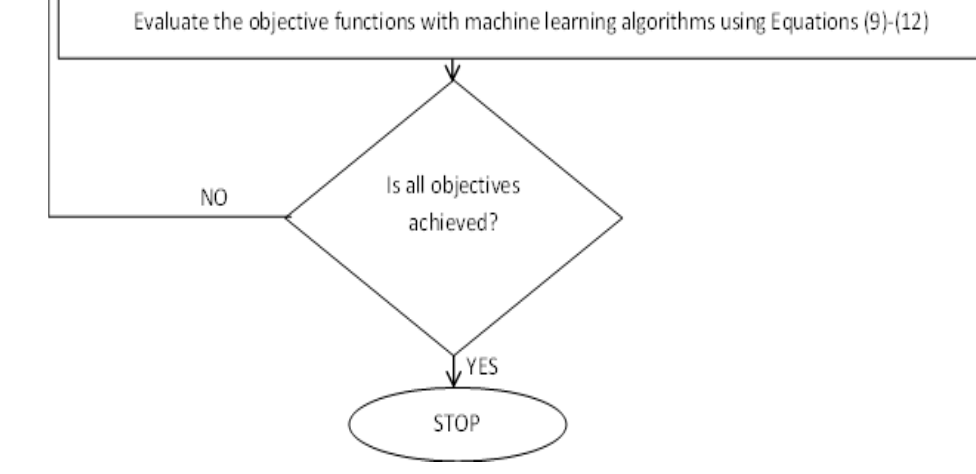
Figure 2. Machine learning with integrated system model. Even in unsupervised machine learning algorithms, the distance of data transmission can be calculated using variable k measurable locations. The Figure 2 depicts the inte- grated system model with machine learning.